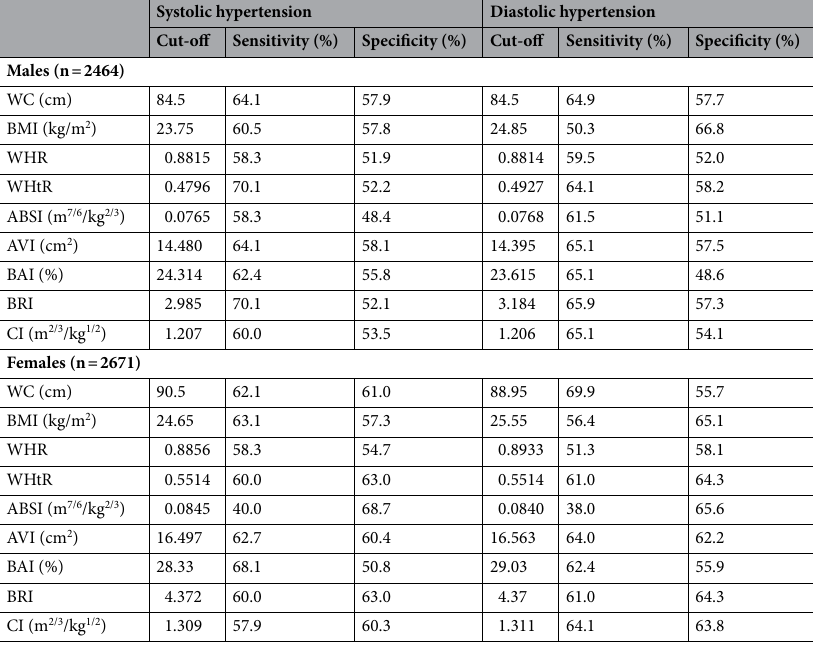
Table 5. ROC determined cut-off, sensitivity and specificity of each anthropometric index for predicting hypertension. ROC receiver operating characteristic curve, WC waist circumference, BMI body mass index, WHR waist-to-hip ratio, WHtR waist to height ratio, ABSI a body shape index, AVI abdominal volume index, BAI body adiposity index, BRI body roundness index, CI conicity index.